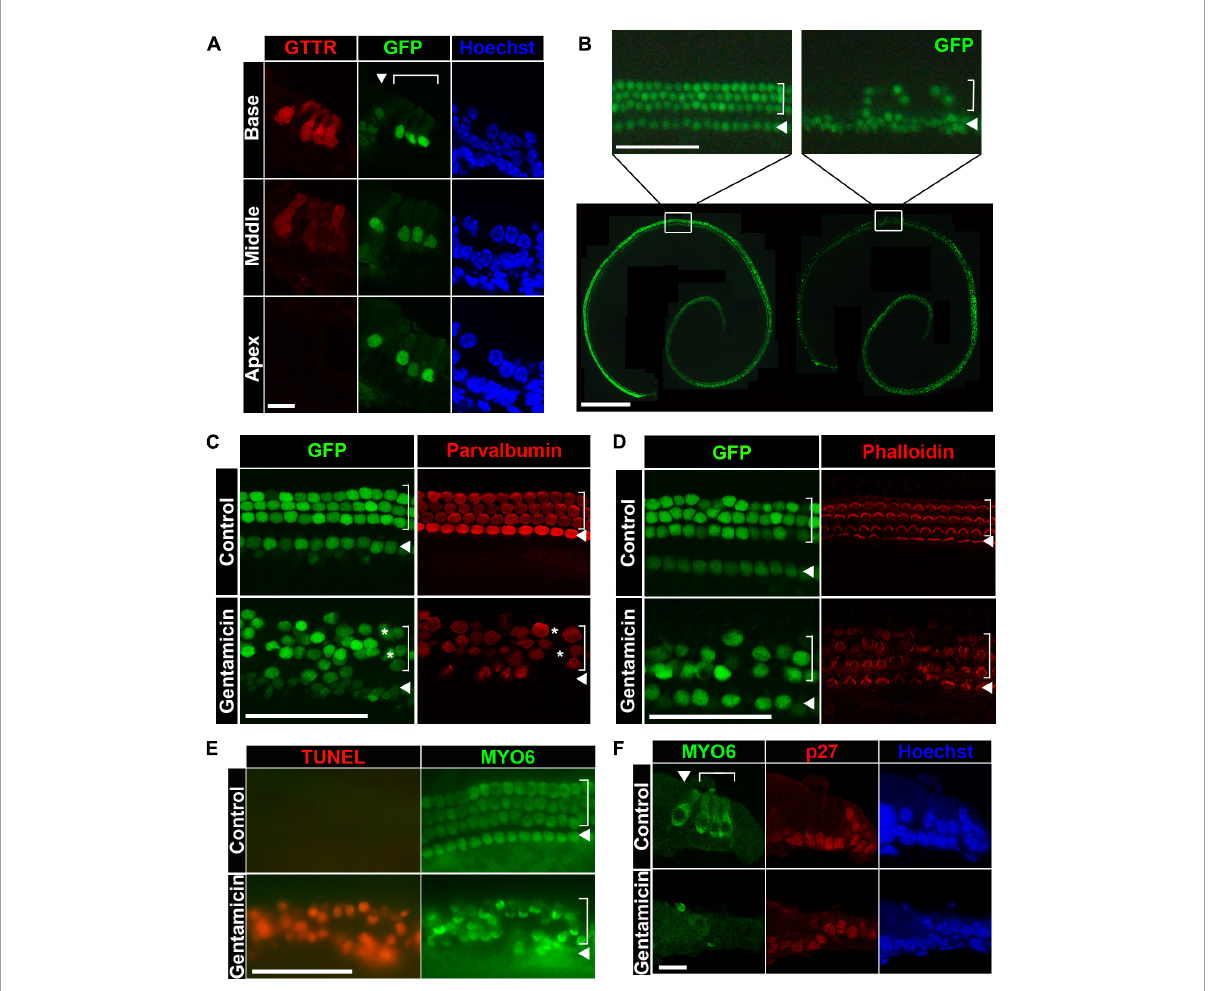
FIGURE1 Gentamicin induces hair cell death through apoptosis in organ of Corti explant cultures. (A) Gentamicin accumulates specifically in hair cells with a base-to-apex gradient shown by cross-sections. GTTR, texas-conjugated gentamicin. GFP expression is under the control of Atoh1 3 (cid:48) enhancer, labeling hair cells. (B) Gentamicin induces hair cell loss in organotypic cultures of cochleae in a base-to-apex wave shown by surface preps. Bottom panel , image of the untreated organ ( left ) and gentamicin-treated organs ( right ) at 24-h timepoint. Top panel , close-up image of untreated organ ( left ) and treated organs ( right ) at the middle-base position showing organized inner and outer hair cells in control organs and diminishing GFP-positive hair cells in gentamicin-treated organs. (C) Immunostaining of hair cell marker Parvalbumin showing that loss of GFP faithfully reflects the loss of hair cells. All hair cells are marked by GFP and stained positive for Parvalbumin in untreated control organs; and in gentamicin treated organs, Parvalbumin staining correlates with GFP staining. A few GFP-positive hair cells are Parvalbumin negative (asterisks), indicating that loss of Parvalbumin precedes the loss of GFP. Images were taken from the base region of the cochleae 18 h after treatment. (D) Immunostaining of hair cell stereocilia by Phalloidin shows the correlation between GFP loss and stereocilia disruption. Phalloidin labels the apical surface of hair cells, indicating healthy, undamaged stereocilia. Gentamicin-treated organs show similar patterns of GFP disappearance and stereocilia loss. Images were taken from the base regions of the cochlea at 18-h timepoint. (E) Hair cells die through apoptosis after gentamicin treatment. TUNEL (terminal deoxynucleotidyl transferase dUTP nick end labeling) signal is observed in hair cells (counterstained with MYO6) in gentamicin-treated organs at 24 h. Images were taken from the base regions of the cochlea. (F) Gentamicin specifically damages hair cells but not supporting cells. Hair cells are positive for MYO6 staining in cross-sections and supporting cells are labeled by p27 staining. Gentamicin-treated organs lose hair cells while supporting cells remain intact. Cultured cochleae were fixed at 24-h timepoint and sectioned for immunostaining, and representative images from the base region are shown. In both cross-sections and surface preps, inner hair cells are indicated by arrowheads and outer hair cells are indicated by brackets. Scale bars, 10 µ m in panels (A,F) , 50 µ m in top panel of panel (B) and in panels (C–E) , 500 µ m in bottom panel of panel (B)